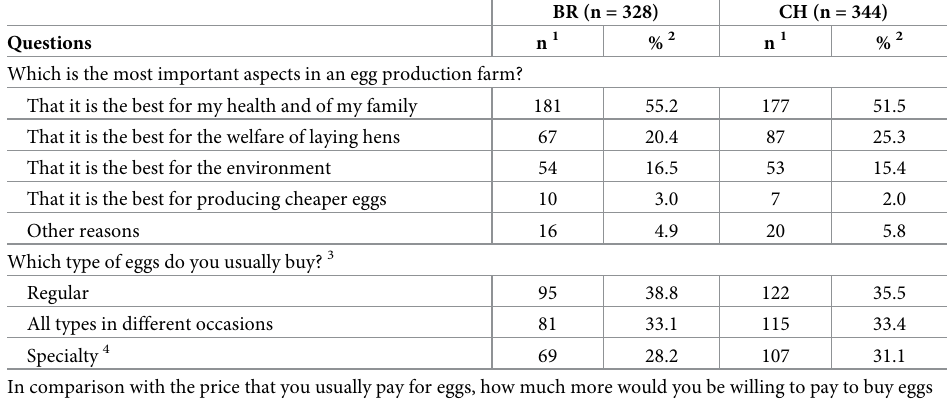
Table 3. Responses of the by Brazilian (BR) and Chilean (CH) consumers to the multiple-choice questions regard- ing the most important aspect in an egg production farm, the type of eggs they usually bought and willingness to pay more to buy eggs produced in the conditions that they described as